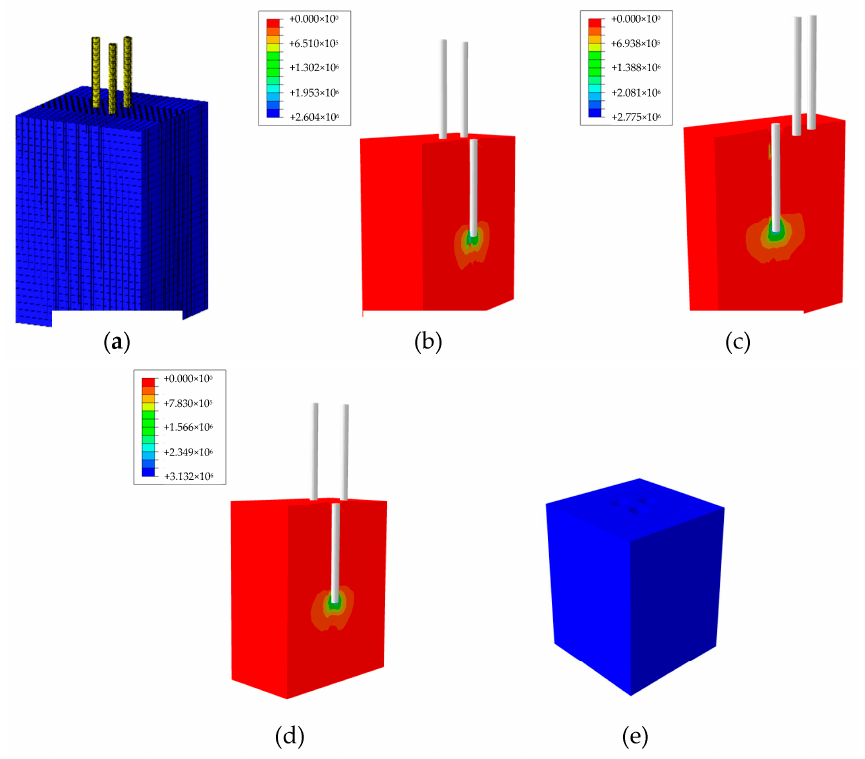
Figure 5. Numerical models of the SP − PSC pile group construction process. ( a ) Total model. ( b ) Pile penetration FEM 1 (Pile 1). ( c ) Pile penetration FEM 2 (Pile 2). ( d ) Pile penetration FEM 3 (Pile 3). ( e ) Formed pile holes.